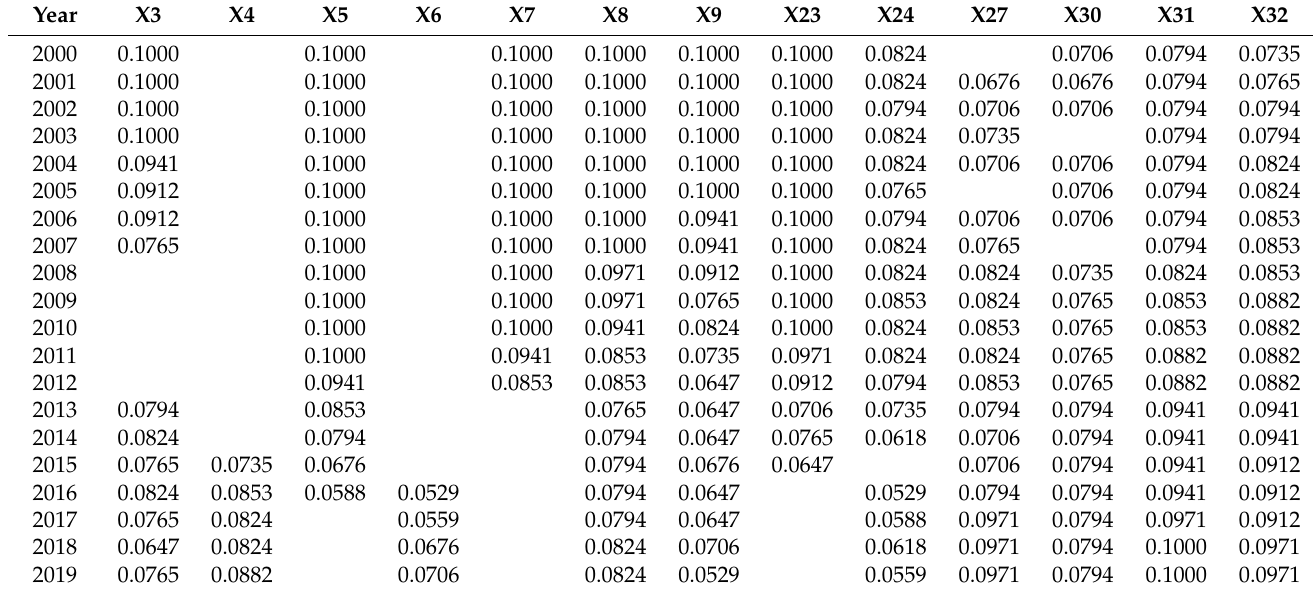
Table 4. Restrictive Indicators of Urban–rural Integration and their Restrictive Degree in North- east